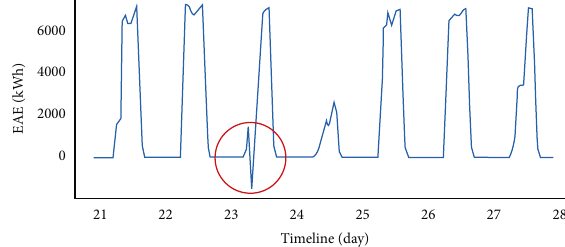
Figure 2: Sample of negative values in the EAE